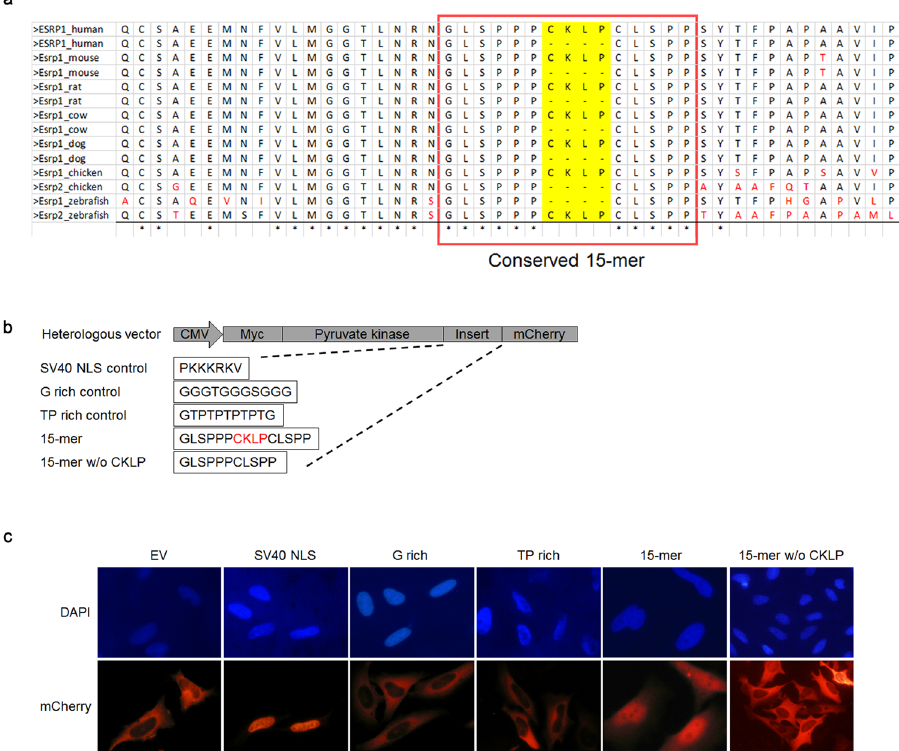
Figure 2. Determination of the Esrp1 sequence element that confers nuclear localization. ( a ) Alignment of Esrp1 and Esrp2 sequences from different species revealed high conservation around the CKLP region. The CKLP peptide is highlighted in yellow, amino acids that are conserved in all species are indicated by an asterisk, and amino acids that are deviated from the conservation are highlighted in red. The region of the proteins represented corresponds to amino acids 522–567 of the 681 amino acids of the human reference protein. The 15 conserved amino acids tested for nuclear localization are boxed. ( b ) Schematic of the reporter and peptide sequences used for transfection and microscopy in ( c ). ( c ) Representative images of HeLa cells (20x) transfected with different reporter vectors depicted in ( b ), from which we concluded that the fifteen amino acid peptide “GLSPPPCKLPCLSPP” is sufficient for nuclear localization. EV indicated the empty reporter